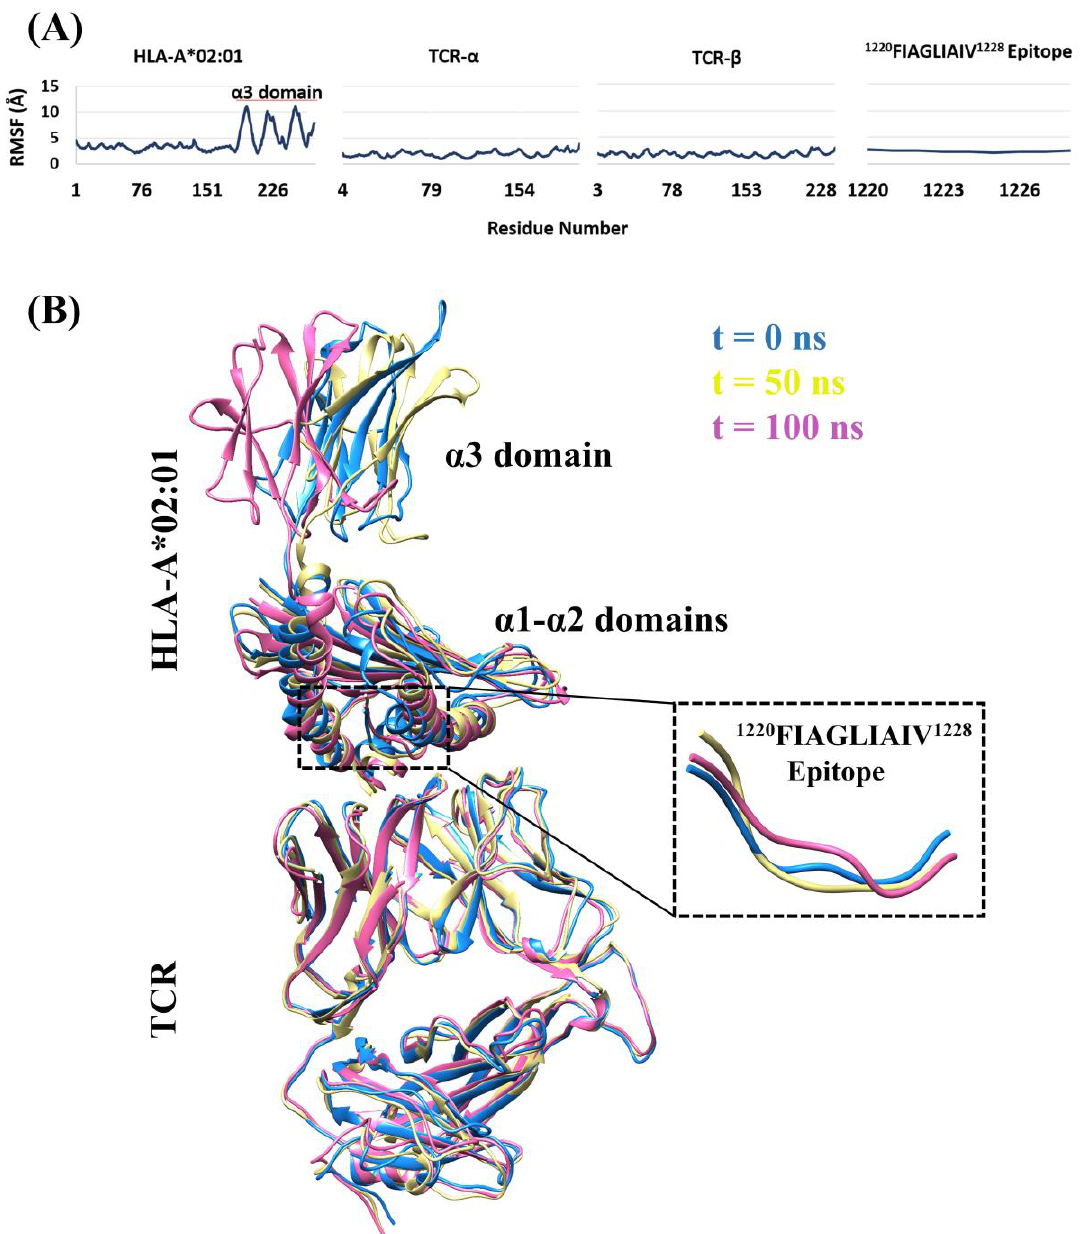
Figure 3. Structural dynamics of the HLA-A*02:01- 1220 FIAGLIAIV 1228 S protein epitope–T cell receptor (TCR) complex during a 100 ns simulation. ( A ) Cα atom root–mean–square fluctuation (RMSF) of the ternary complex. ( B ) Superimposed conformations of the complex sampled at 0 ns (blue), 50 ns (yellow) and 100 ns (pink) of the simulation. Results from the first of three independent MD simulations are illustrated here.